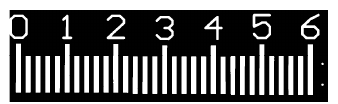
Fig. 5. Complete image of the scale after the registration.